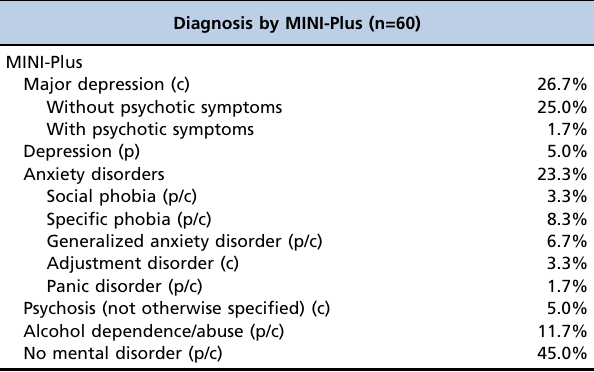
Table 3 - Features of acute ischemic stroke in a sample of 60 patients.